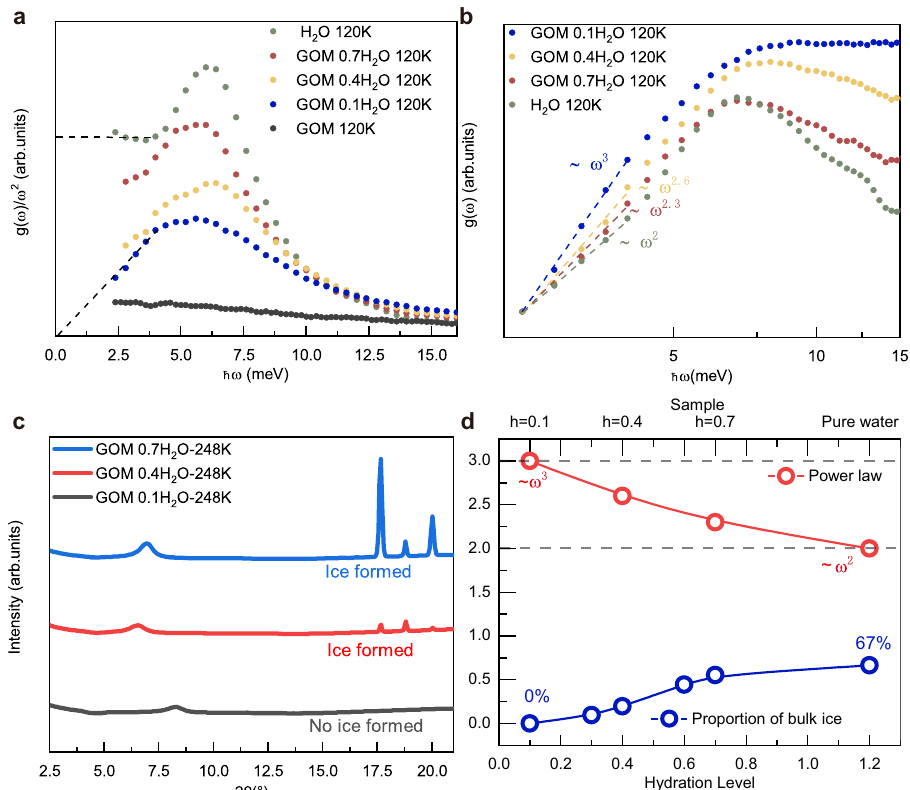
Fig. 3 The evolution of VDOS for con fi ned ice upon changing the con fi ment size. a The experimental VDOS normalized by ω 2 vs. frequency for bulk ice (green), GOM sample at h = 0.7 (red), 0.4 (yellow), 0.1 (blue) and the dry GOM (gray), respectively. The horizontal dashed line guides the eyes towards the Debye level for the bulk sample. The diagonal dashed line guides the eye towards the g ( ω ) ~ ω 3 low frequency scaling. The blue data correspond to those reported in the panel (b) of Fig. 2. b The log-log scale plot of the original non-normalized VDOS corresponds to the data in panel ( a ). All datasets are fi tted in the same energy interval (from 2.4 to 4 meV) and rescaled such that the fi rst data points overlap for better comparison. c The X-ray diffraction data for samples at different hydration levels. d The fi tting power of the low frequency VDOS data for different hydration levels (red). The dashed lines indicate the ω 3 scaling and the standard quadratic Debye's law. The DSC data showing the mass proportion of bulk ice for the corresponding hydration levels